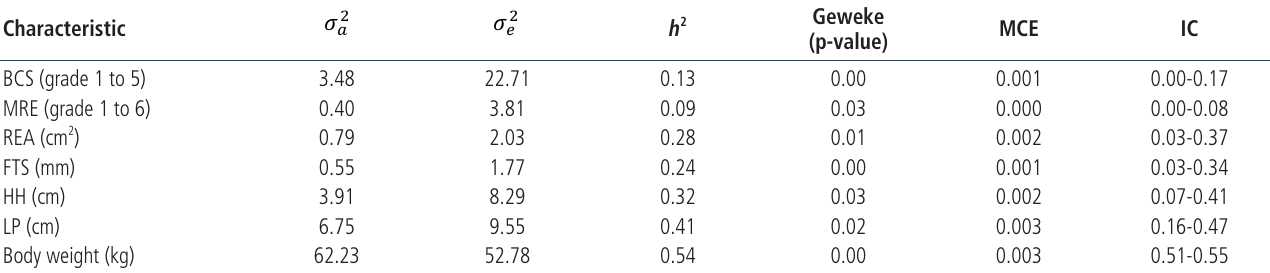
Table 3. Estimates of the (co) variance and heritability (h²) components of body condition score characteristics (BCS), the loin marbling (MRE), ribeye area (REA), fat thickness of the sternum (FTS), hip height (HH), the leg perimeter (LP) and body weight, obtained in two-trait analysis Characteristic